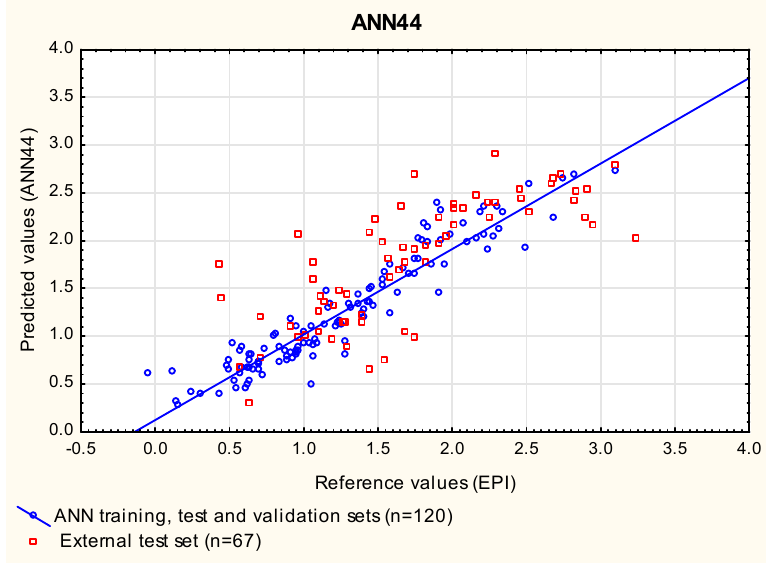
Figure 8. ANN44 model—predicted vs. reference log BCF values.